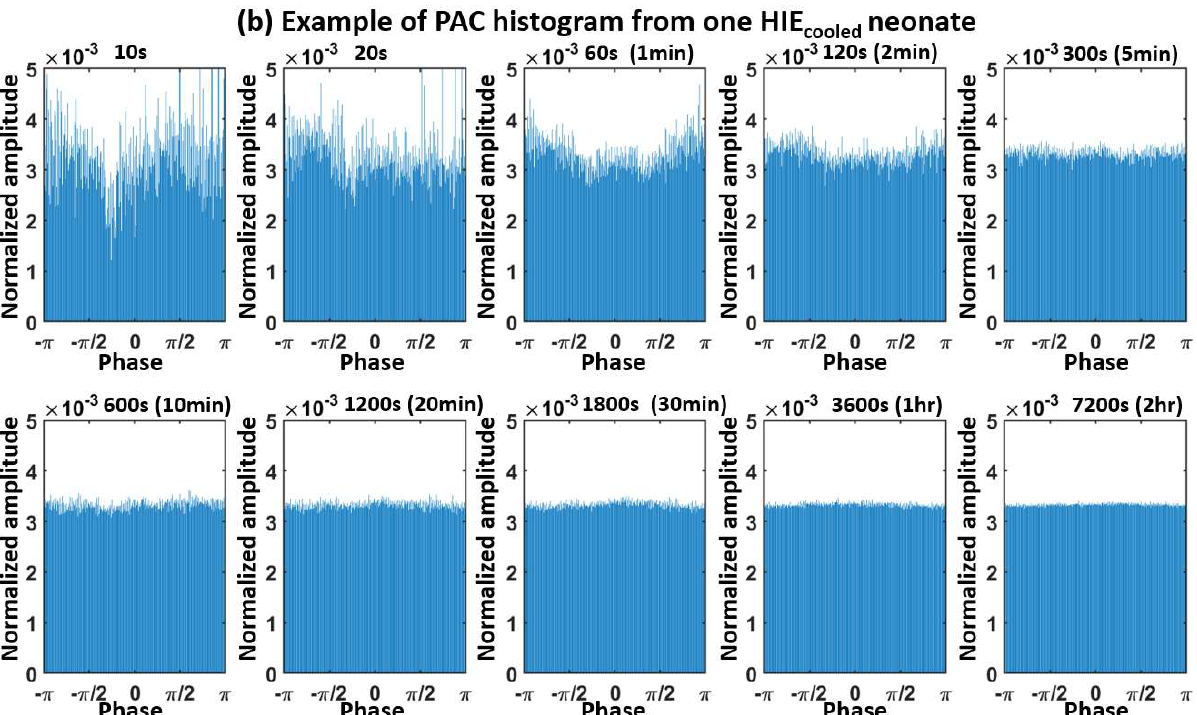
Figure A1. Histograms of PAC calculation, showing the coupling relationship between the normalized amplitude of the fast oscillation (18–22 Hz in this example) versus the phase of the slow oscillation (1–2 Hz in this example) generated with a window length of 10 s, 20 s, 60 s (1 min), 120 s (2 min), 300 s (5 min), 600 s (10 min), 1200 s (20 min), 1800 s (30 min), 3600 s (60 min), 7200 s (120 min) of EEG signal, respectively, from ( a ) HIE mild neonate; ( b ) HIE cooled neonate. PAC: Phase Amplitude Coupling.